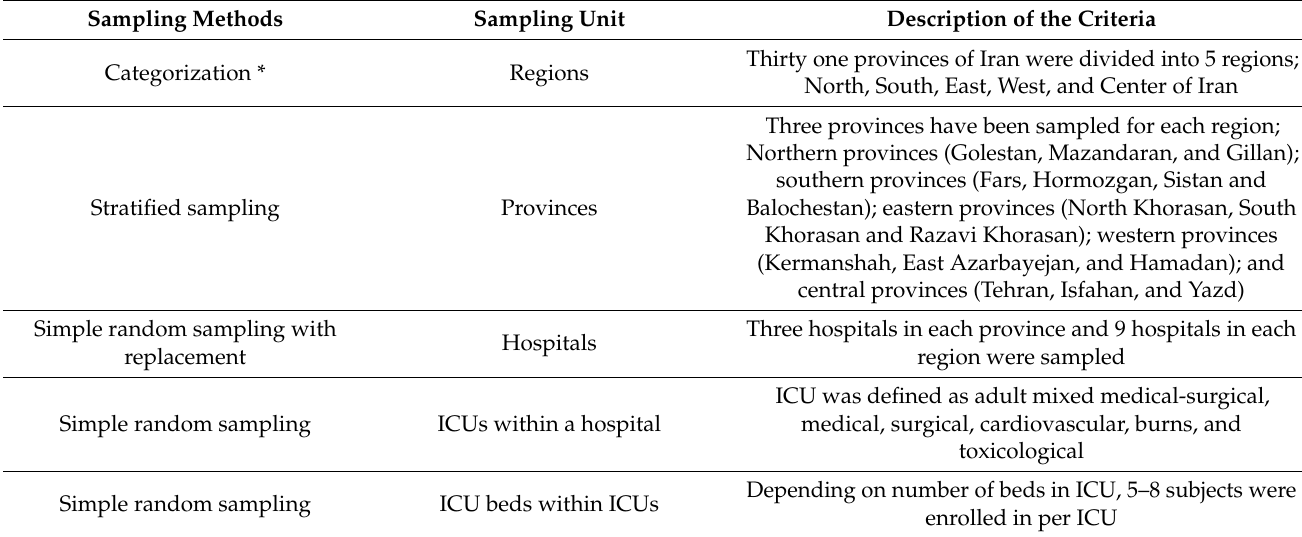
Table 1. Criteria for sampling hospitals for data